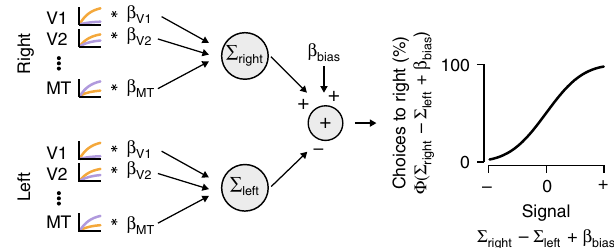
Fig. 4 Readout linking model. The linking model simulates the cortical response evoked by each dot patch according to an existing framework 48 , which parameterized the contrast response function (orange curves) as a Naka – Rushton and the coherence response function (blue curves) as linear or a saturating exponential function. The model weights the cortical responses from each visual area ( β values) evoked by the stimulus (Right or Left) according to the current task. The model then takes the difference between the signals evoked by each stimulus, plus a bias term ( β bias ) to account for any individual observer ’ s bias to choose one response over the other. To convert from this weighted signal to probability of choosing the patch on the right, the signal is passed through a cumulative normal distribution (curve on right). The linking model is analogous to probit regression with nonlinear input perceptual sensitivity changed when observers switched task. If sensory changes were suf fi ciently large, then the readout could be fi xed between task conditions. Such a fi xed-readout model would only require a single set of cortical area weights with changes in perception accounted for only by changes in sensory responses.